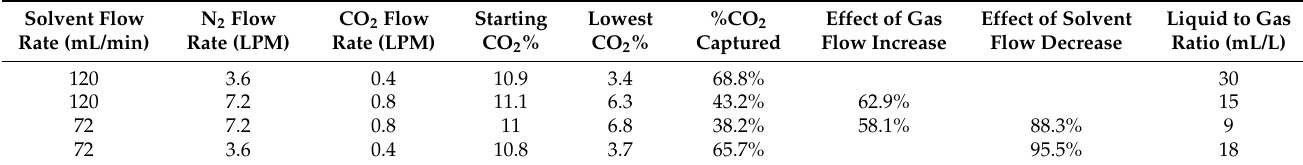
Table 4. Effects of solvent and gas flow rates on CO 2 capture efficiency of surface-only covalent 3-D aggregate enzyme